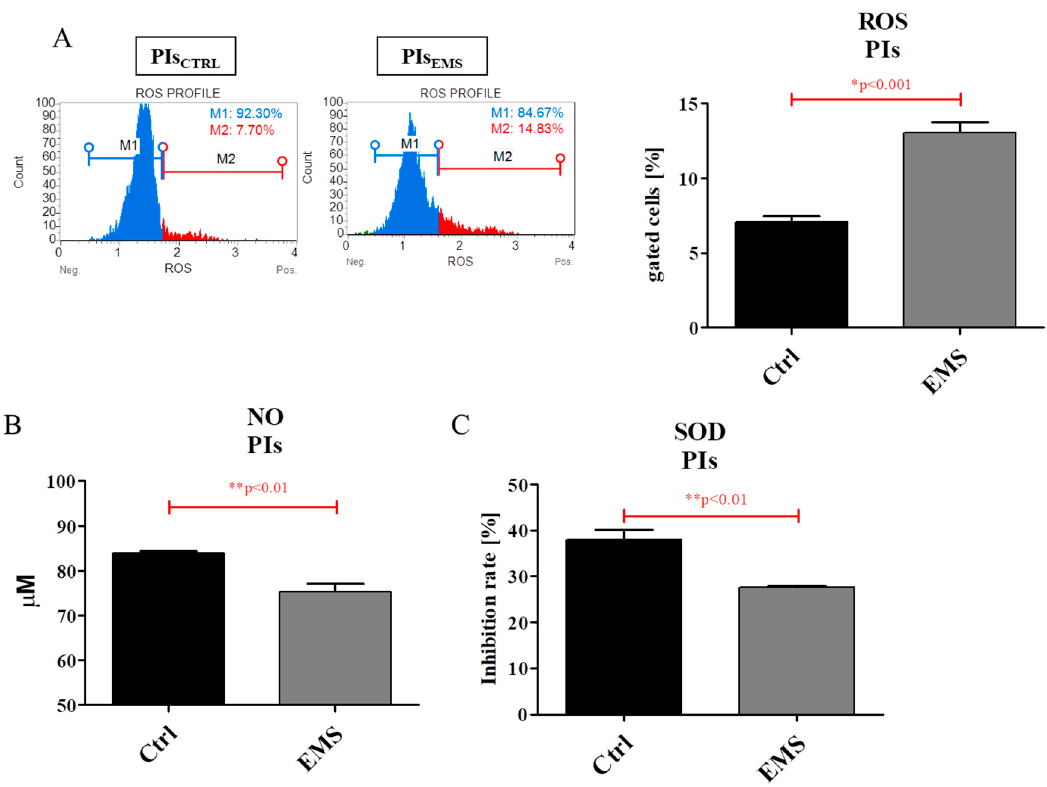
Figure 9. Oxidative stress factors in PIs. Using a MUSE Cell Analyzer, the amount of ROS was established ( A ). Moreover, using colorimetric assays, both NO ( B ) and SOD ( C ) levels were evaluated. The obtained results indicate increased accumulation of oxidative stress in PIs EMS , with simultaneously decreased antioxidative capacities. Results expressed as mean ± S.D. * p < 0.05.